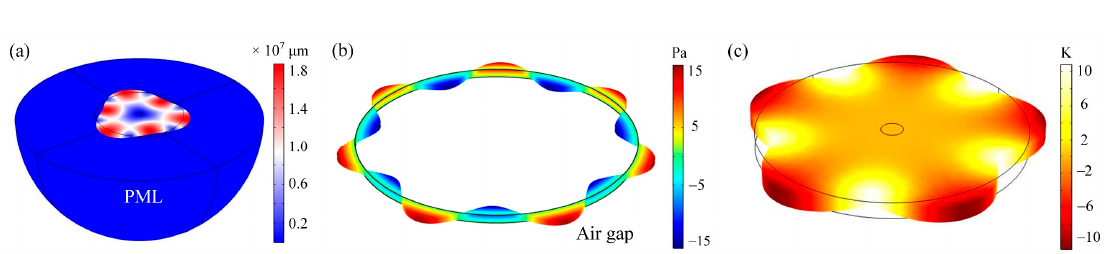
Figure 2. The simulated displacement distribution of the WGM resonator as well as the substrate ( a ), the varied pressure profile of the air gap ( b ), and the temperature distribution ( c ).